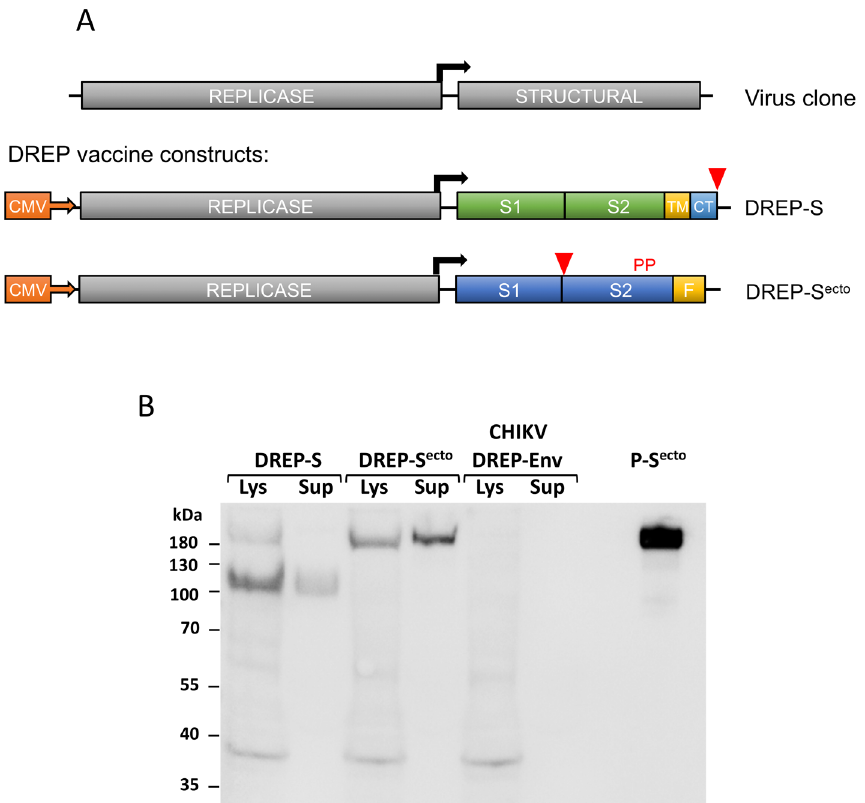
Figure 1. Schematic illustration of the DREP vaccine candidates encoding SARS-CoV-2 spike (S) protein and analysis of expression form the vaccine constructs. ( A ) Top, an infectious clone of an alphavirus showing the replicase and structural coding regions placed under the viral subgenomic promoter (black arrow). To target SARS-CoV-2 we replaced the alphavirus structural genes with the genes encoding the spike protein of SARS-CoV-2. The DREP-S construct codes for the SARS-CoV-2 spike protein with an 18-aa deletion in the cytoplasmic tail region, while S ecto codes for the prefusion-stabilized spike ectodomain with a T4 fibritin (foldon, F) trimerization domain, two stabilizing prolines (PP) and a mutated furin cleavage site; TM, transmembrane domain; CT, cytoplasmic tail. Deletions are indicated by red arrows. ( B ) HEK293T cells were transfected with either DREP-S or DREP-S ecto construct, or DREP encoding CHIKV spike glycoproteins as negative control. Cell lysates (Lys) and supernatants (Sup) were analyzed by Western blot using alpaca anti-spike serum. S ecto protein was used as positive